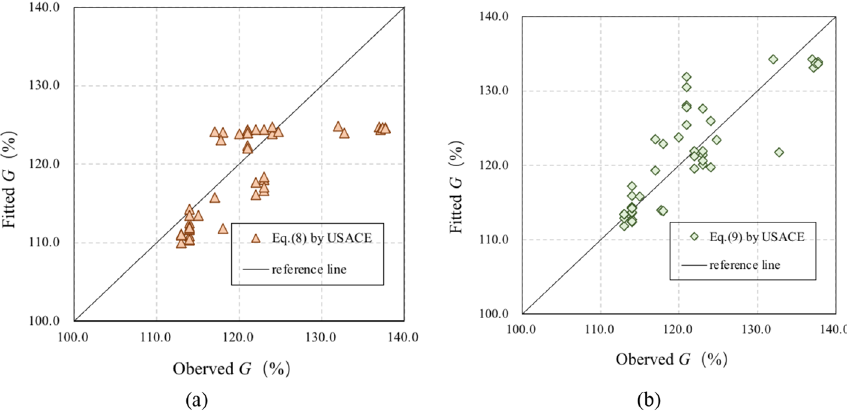
Figure 4. Comparison between observed and fitted G with the USACE proposed correlations: ( a ) Eq. (8); ( b ) Eq. (9).